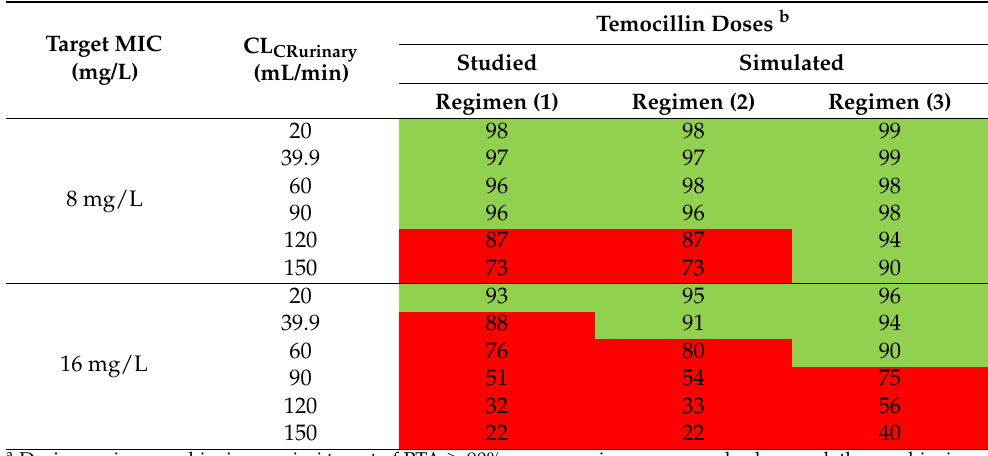
Table 6. Probability of target attainment (PTA) a (in percentages) in the ascitic fluid between 24 to 96 h for the various temocillin dosing regimens according to the CL CRurinary values for a target MIC of 8 and 16